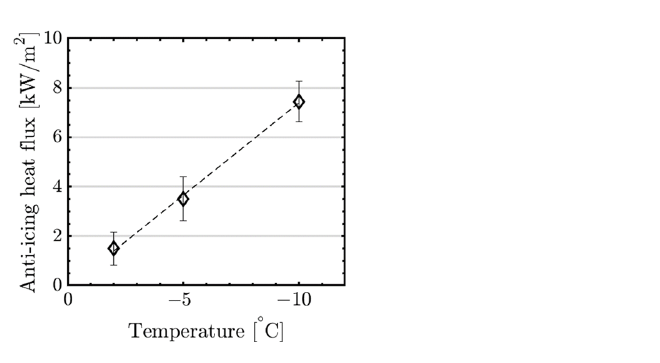
Figure 9. Minimum required heat fluxes for anti-icing at different temperatures.